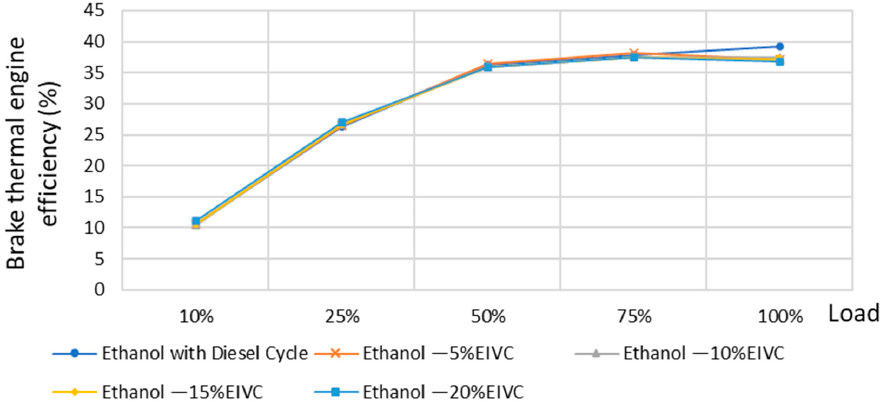
Figure 17. BTEE(%) of ethanol engine with EIVC Miller Cycle.